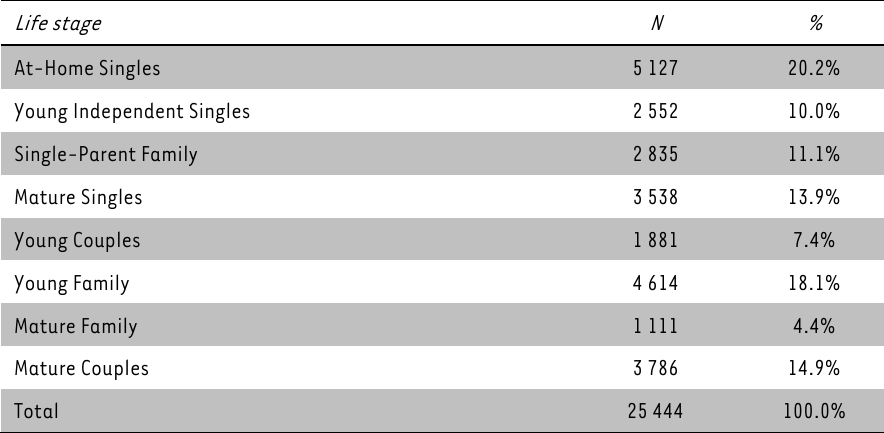
TABLE 1: Respondents per life stage